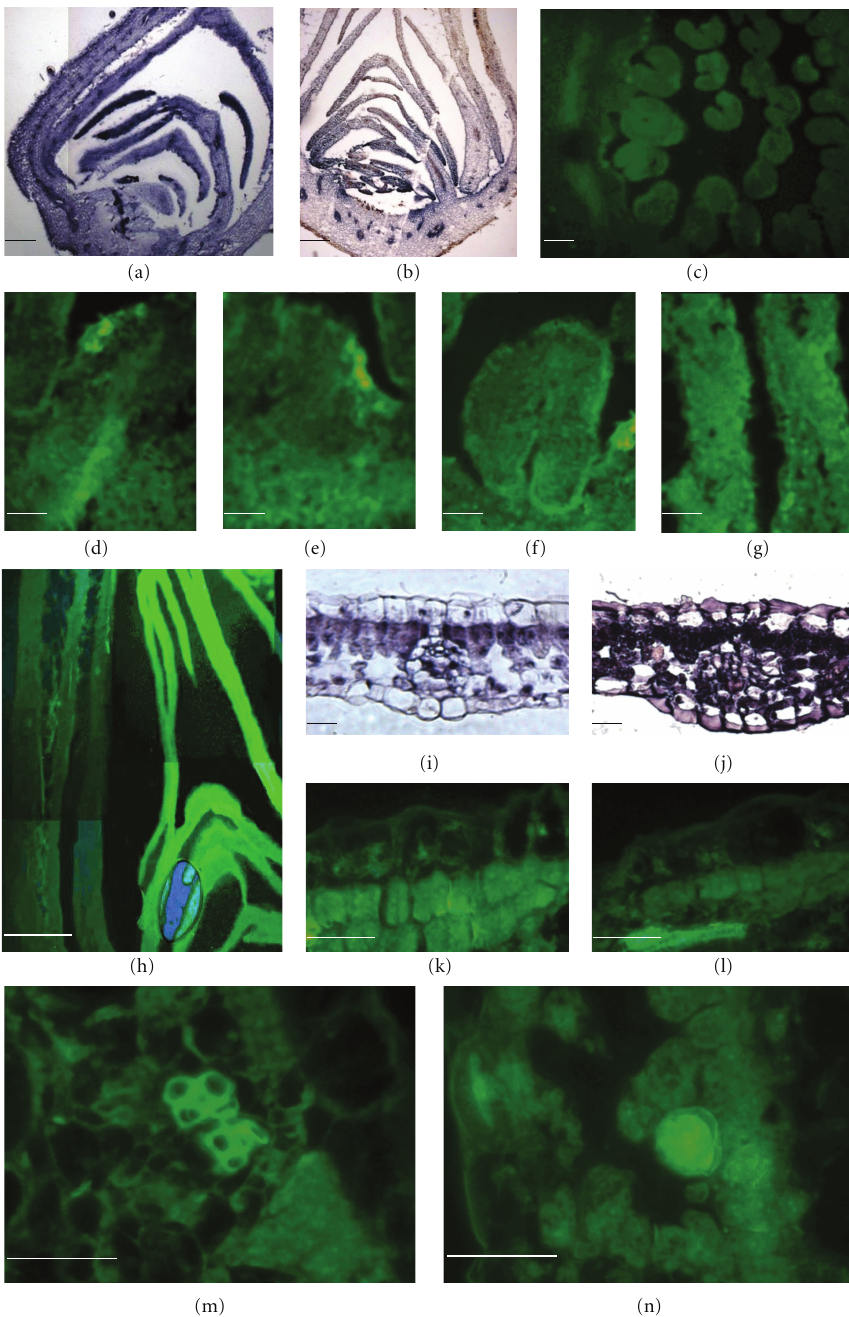
Figure 2: In situ RT-PCR on Rosa hybrida buds and leaves (a) digoxygenilated sections of flower bud, β -actin, (b) digoxygenilated sections of flower bud, Rh FUL gene, (c) biotinylated sections of flower bud, RhFUL gene, (d)–(g) fluoresceinated sections of flower bud, β -actin, (h) fluoresceinated sections of flower bud, RhFUL gene, (i) digoxygeninylated sections of leaf, β -actin, (j) digoxygeninylated sections, RhFUL gene, (k) biotinylated sections, β -actin, (l) biotinylated sections of leaf, RhFUL gene, (m) fluoresceinated sections of leaf, β -actin, (n) fluoresceinated sections, of leaf, RhFUL gene. Bar = 50 μ